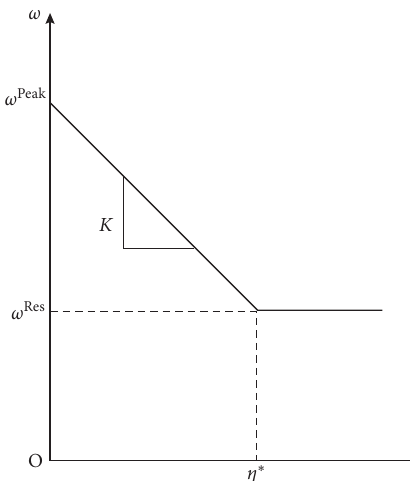
Figure 2: Relationships between softening coefficient and H-B